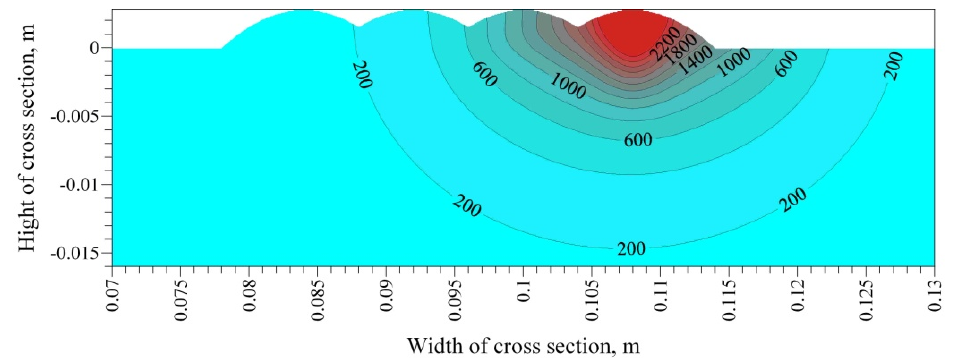
Figure 10. Temperature field (°C) in cross ‐ section during the application of fourth weld 0.3 s after passage of the electrode over this cross ‐ section.